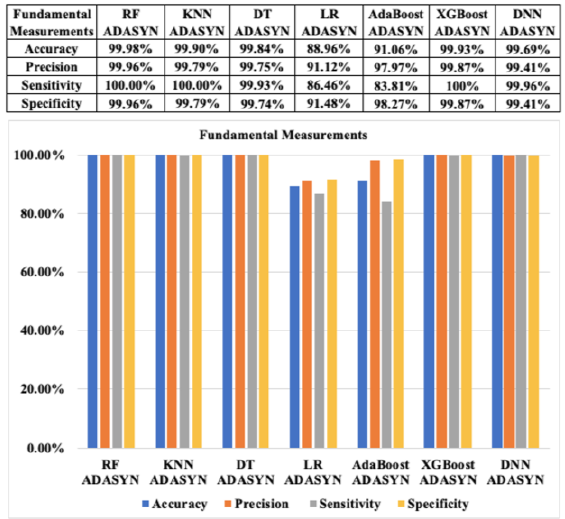
Figure 13. Fundamental classification performance measurements of ML algorithms with ADASYN based on resampling approach 1.